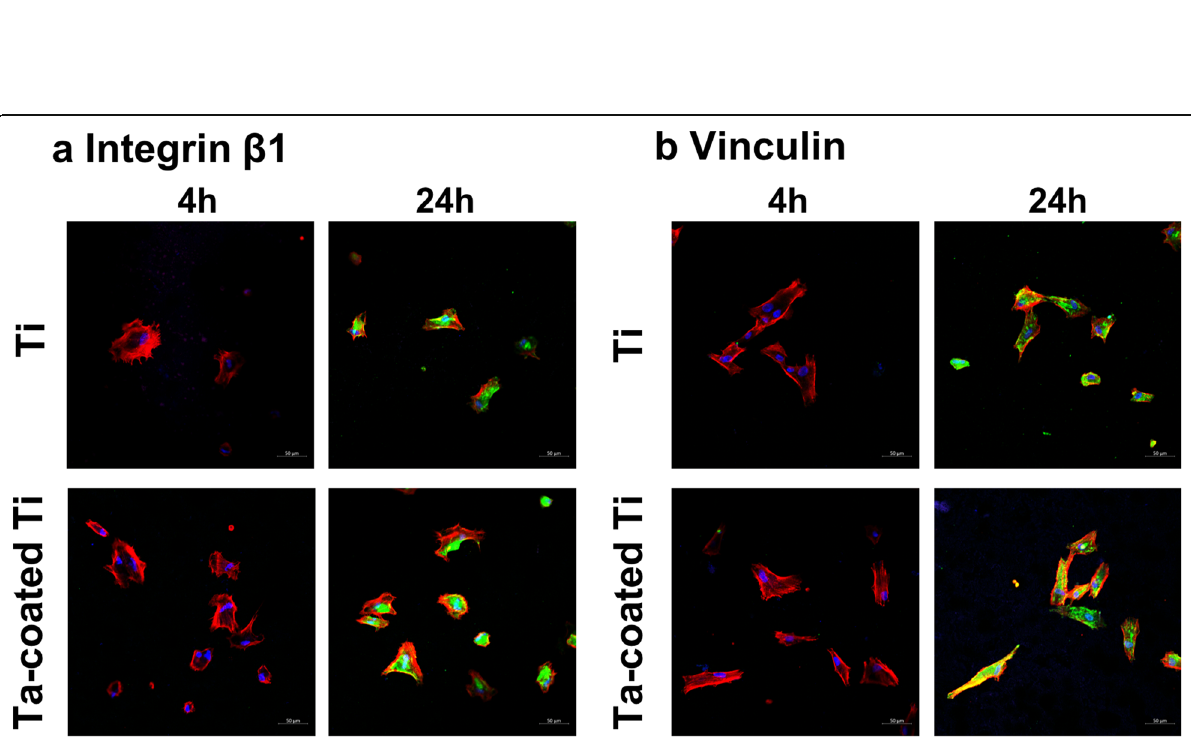
Fig. 6 Immunofluorescence expression of adhesion-related proteins detected by confocal laser scanning microscopy. a Expression of integrin β 1 (green) of HGFs from titanium plates and tantalum coated titanium plates at 4 h and 24 h after seeding. b Expression of Vinculin (green) of HGFs from titanium plates and tantalum coated titanium plates at 4 h and 24 h after